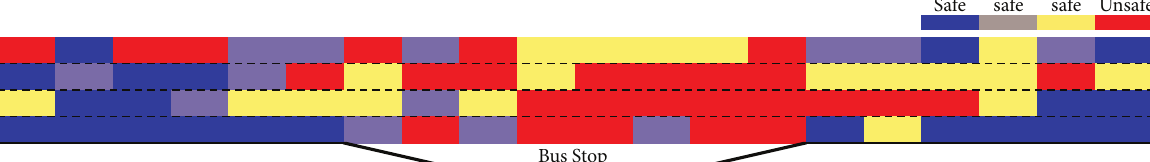
Figure 11: Results of internal risk assessment of bus stops.